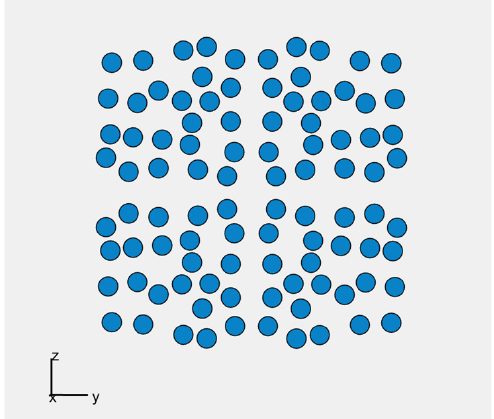
Figure 9. An acoustic camera in coordinate system, x being the broadside direction, consisting of four optimal panels from Figure 8 arranged in such a way that the second panel is the axial symmetry of the first panel with respect to the x-axis, the third panel is the axial symmetry of the first panel with respect to the y-axis, and the fourth panel is the central symmetry of the first panel with respect to the origin— Acoustic Camera 3 .